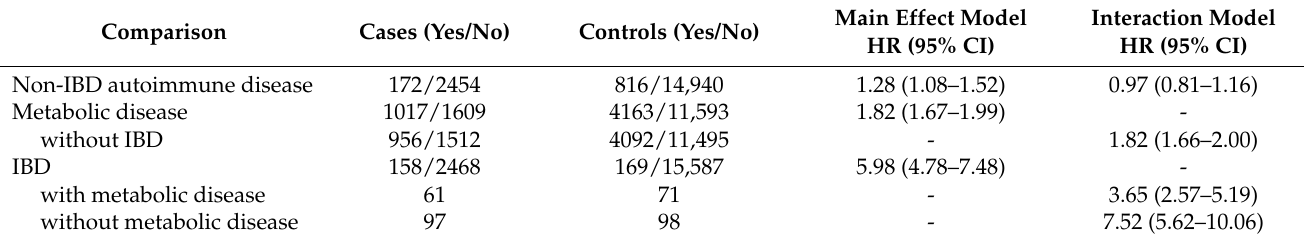
Table 3. Conditional logistic regression models of the incidence of early-onset colorectal cancer conditioning on matched risk set, with covariates: indicators for non-IBD autoimmune disease, metabolic disease, IBD, and an interaction term between metabolic disease and